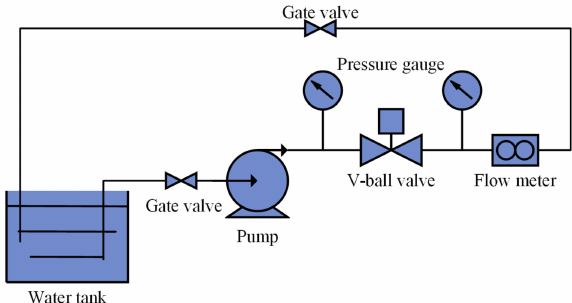
Figure 3. The sketch of the test